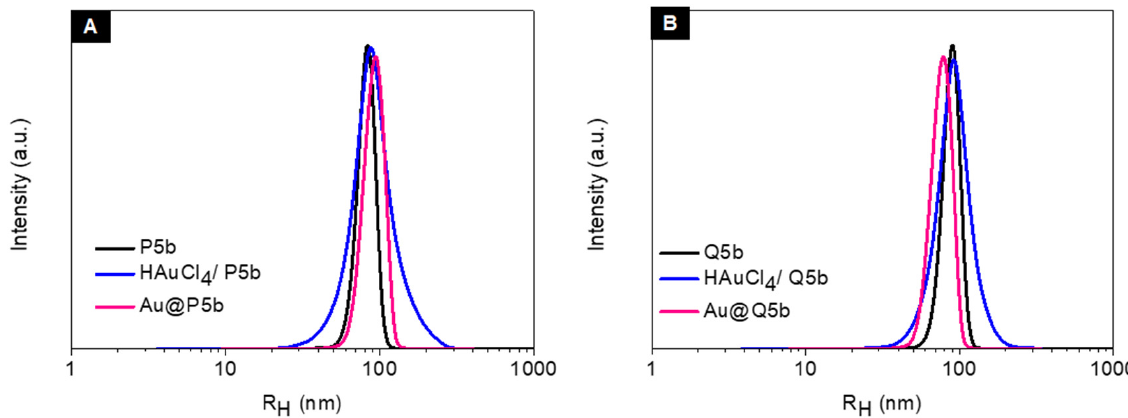
Figure 1. Size distribution of bare polymeric micelles (black), HAuCl 4 doped micelles (blue) and Au@pentablock terpolymer nanoparticles (magenta) prepared with P5b ( A ) and Q5b ( B ) in pbs,